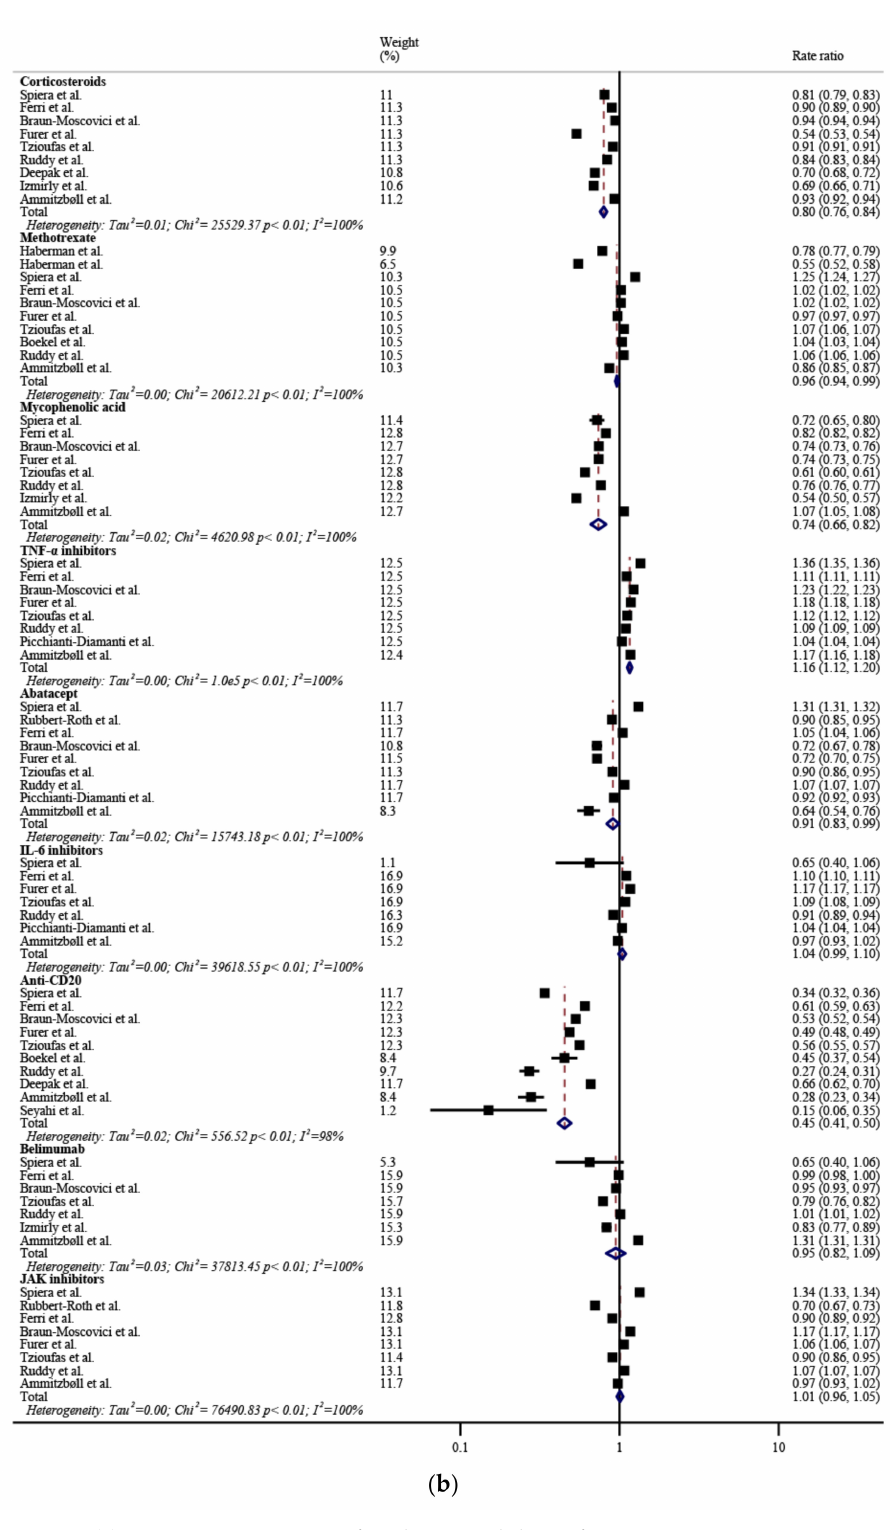
Figure 3. ( a ) Seroconversion rates after the second dose of mRNA vaccines in certain medication users, and ( b ) the seroconversion rate ratios between medication users and non-users in rheumatic patients. The black squares represent the effect estimates of the individual studies and the diamonds represent the summary effect estimates. IL, interleukin; JAK, Janus kinase; TNF, tumor necrosis